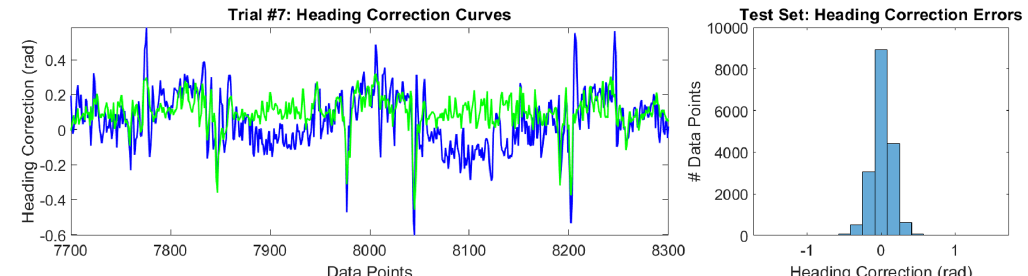
Figure 15. Test Set Heading Correction Errors: ( Left Plot ) A five-minute section of Trial #7’s heading correction curve is shown, where the estimated heading correction (Green line) is compared against the ground truth heading correction (Blue line). ( Right Plot ) Distribution of the heading correction errors between the estimated and ground truth heading corrections. Each bin has a width of 0.17 radians.